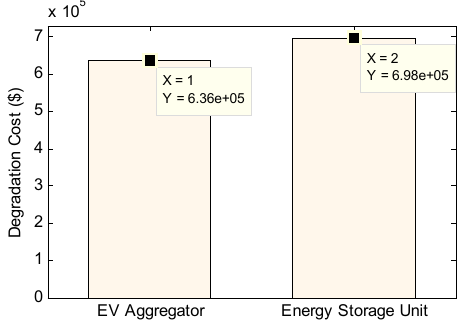
Figure 15. Actual degradation cost for the cases of the EV aggregator and energy storage unit.